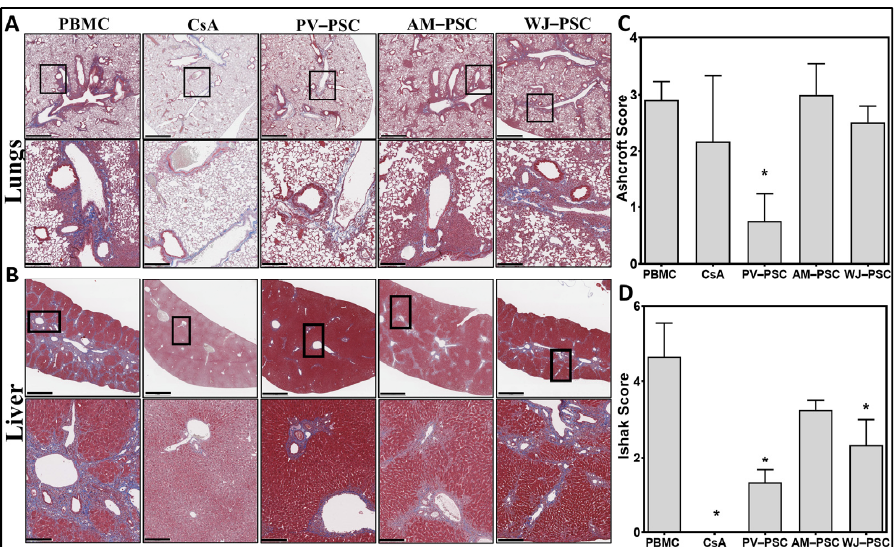
Figure 5. Placenta PSC preferentially diminishes fibrosis in the lungs and liver of GvHD mice as compared with amnion or Wharton’s jelly PSCs. Representative histological images of mice lung ( A ) and liver ( B ) tissues stained with Masson’s trichrome. Fibrotic pathological scoring of lung fibrosis by the Ashcroft score ( C ) and, liver fibrosis by the Ishak score ( D ). Statistical analysis is represented by a one-way ANOVA with Dunnet’s post hoc test. * p < 0.05, n = 3. Upper row scale = 1 mm; lower row scale = 200 µ m. Abbreviations: human peripheral blood mononucleated cells (huPBMC), human perinatal stromal cells (huPSCs), amniotic perinatal stromal cells (AM-PSC), placental villi perinatal stromal cells (PV-PSC) and Wharton’s jelly perinatal stromal cells